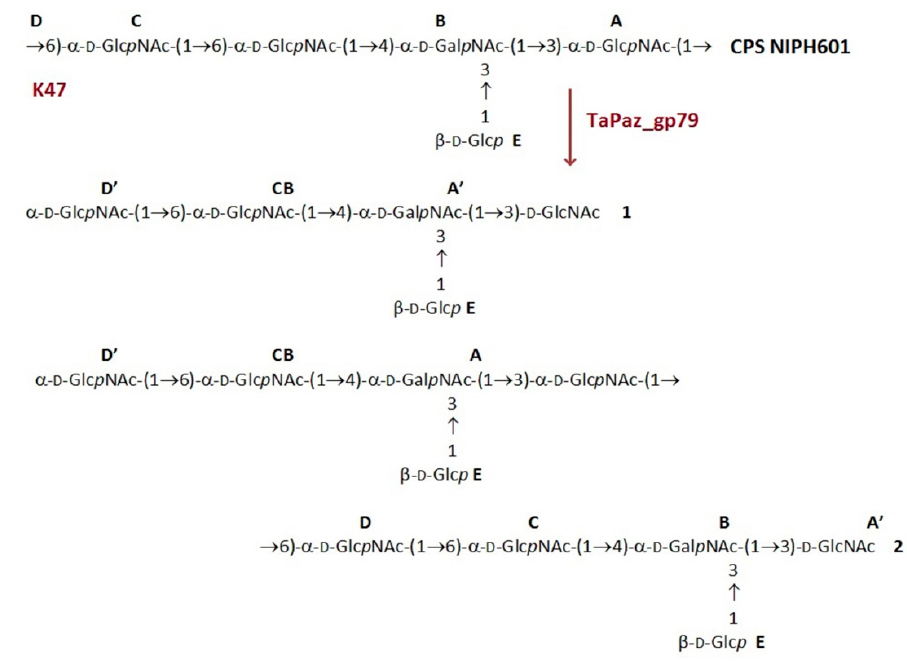
Figure 6. Cleavage of the K47 CPS of A. baumannii NIPH601 with TSD TaPaz_gp79 giving rise to oligosaccharides 1 and 2 corresponding to a monomer and a dimer of the K unit, respectively.